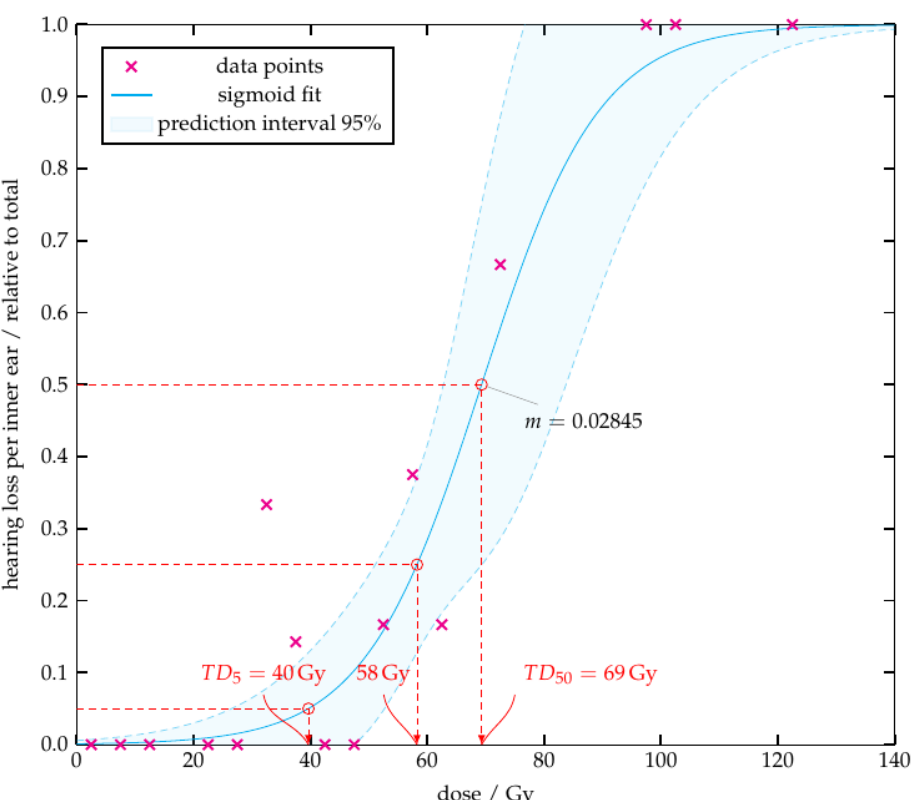
Figure 5. Inner ear side effects depending on maximum radiation dose.The curve describes the incidence of inner ear side effects depending on the dose administered to the inner